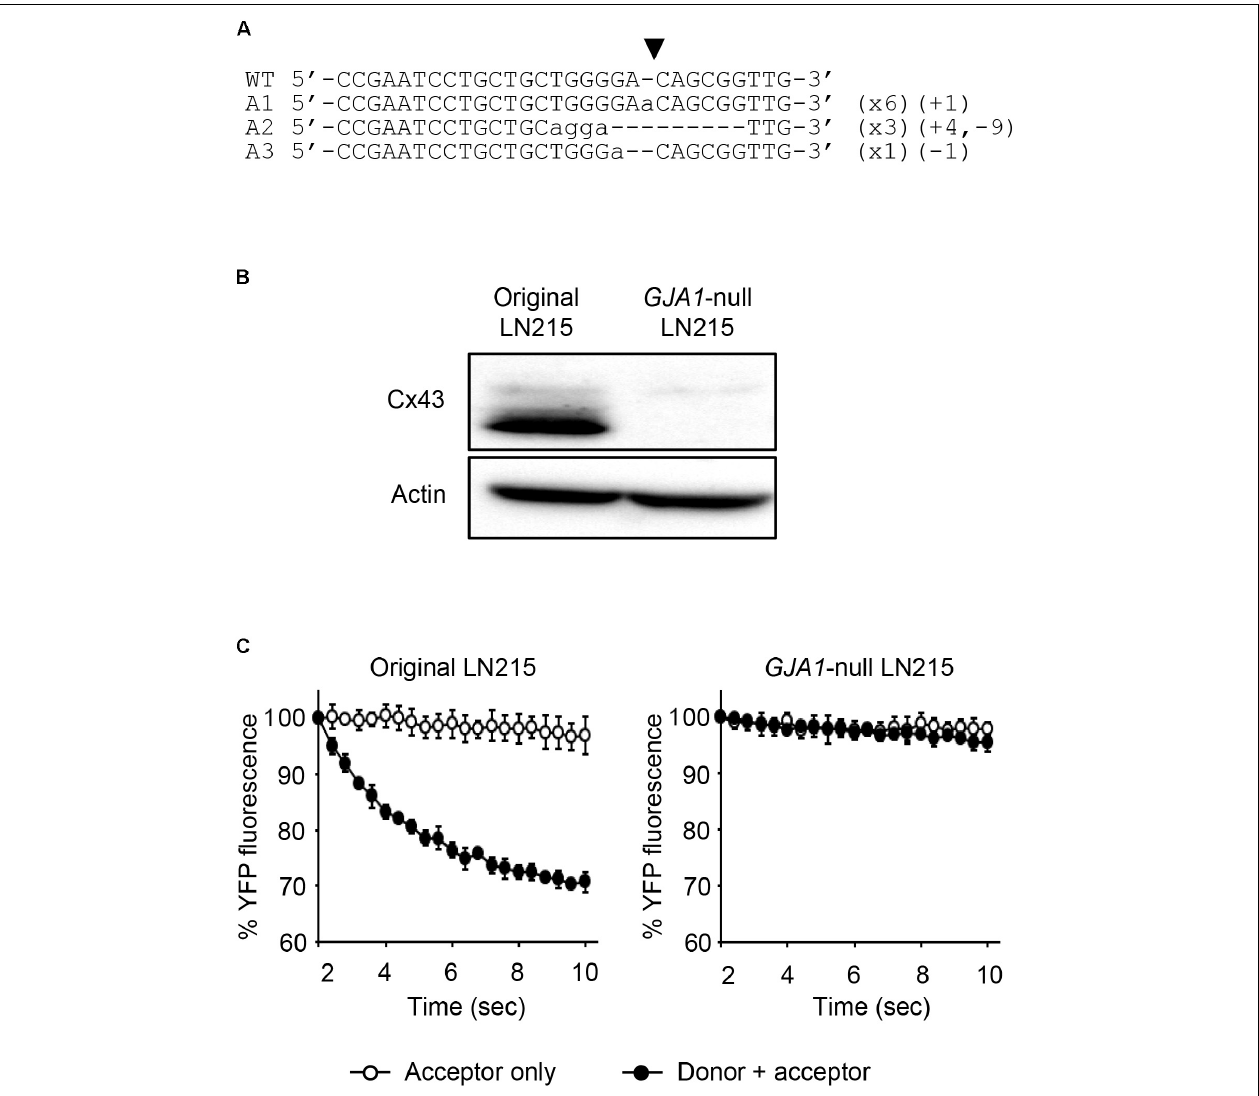
FIGURE 8 | Validation of GJA1 -null LN215 cells. The genomic DNA sequence alignment of the original and GJA1 -null LN215 cells in the GJA1 region targeted by the Cas9 system (A) . Ten TA-clones were read, and three types of alleles were identified. Dashes and lower-case letters indicate deleted and inserted residues, respectively. xN, +N, and –N represent the numbers of the TA-clones among the 10 clones inserted, and the deleted bases, respectively. A1, A2, or A3 are three types of alleles. The inverted triangle indicates the cleavage site by Cas9 in GJA1 . WT, wild-type. The immunoblots showing Cx43 and actin expression of the original and GJA1 -null LN215 cells (B) . The images before cropping are also presented in Supplementary Figures 2A,B. I-YFP GJIC assay using the original ( C , left) and GJA1 -null ( C , right) LN215 cells. The acceptor cells only or the 2:1 mixture of donor and acceptor cells were plated on 96-well plates before the I-YFP assay. The percentage of YFP fluorescence was plotted against assay time. The open and filled circles indicated the acceptor only and donor + acceptor groups, respectively. The data are the mean ± SD ( n =